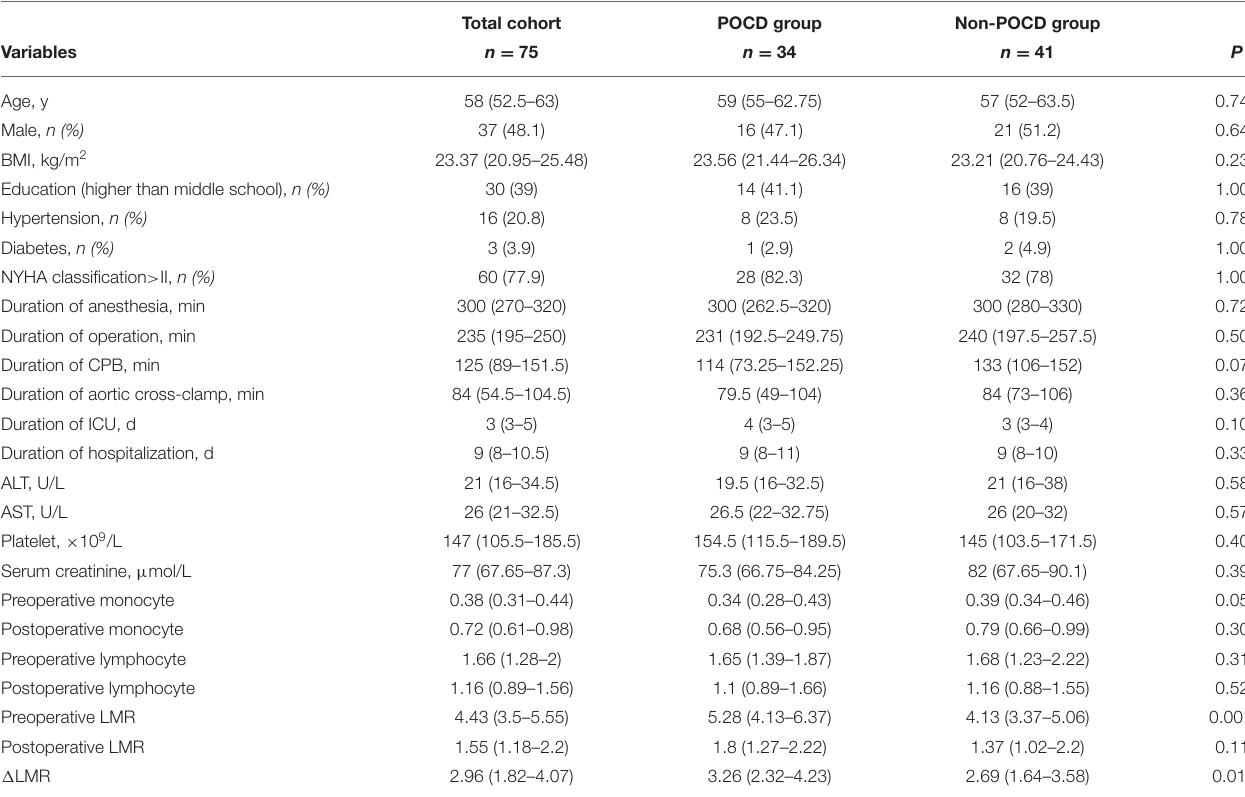
TABLE 1 | Clinical features of the total cohort, POCD group, and non-POCD group.